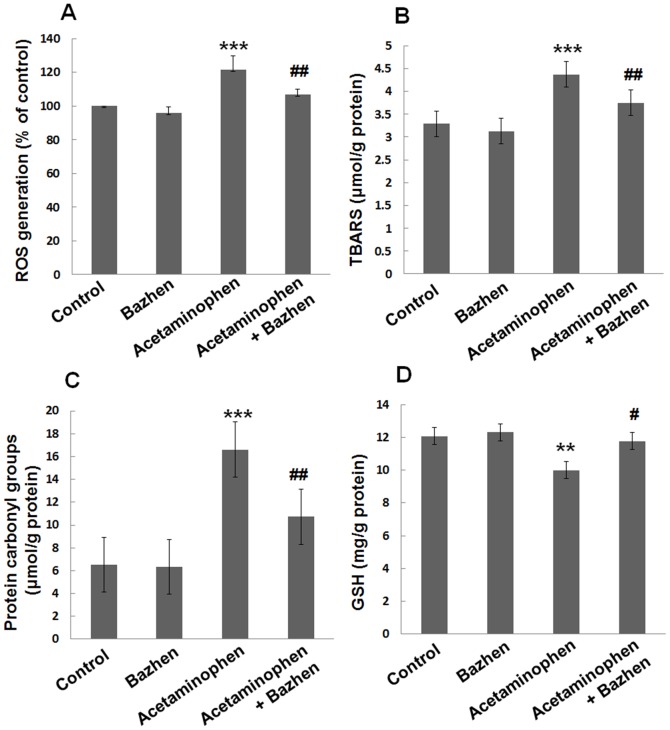
Effect of Bazhen decoction on hepatic ROS, TBARS, protein carbonyl group and GSH levels in acetaminophen intoxicated mice.(A) ROS, (B) TBARS, (C) protein carbonyl group and (D) GSH. Values are expressed as means ± SD of 12 animals in each group. Significance difference were ***p<0.001 or **p<0.01 as compared with the control; ##
p<0.01 or #
p<0.05 as compared with acetaminophen group.